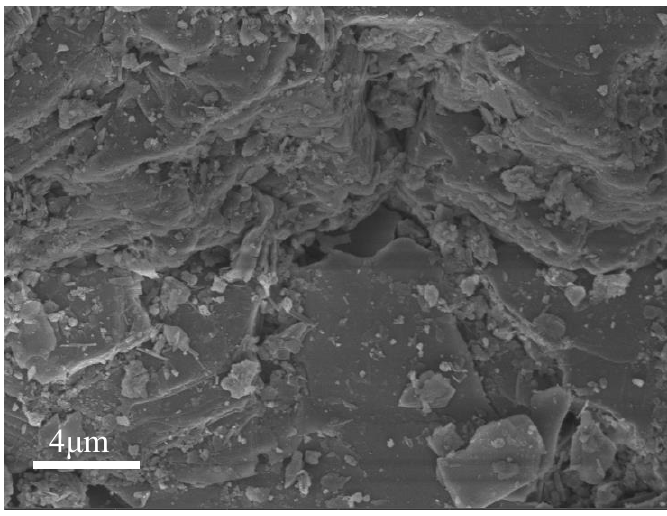
Figure 3. SEM image of ITs.